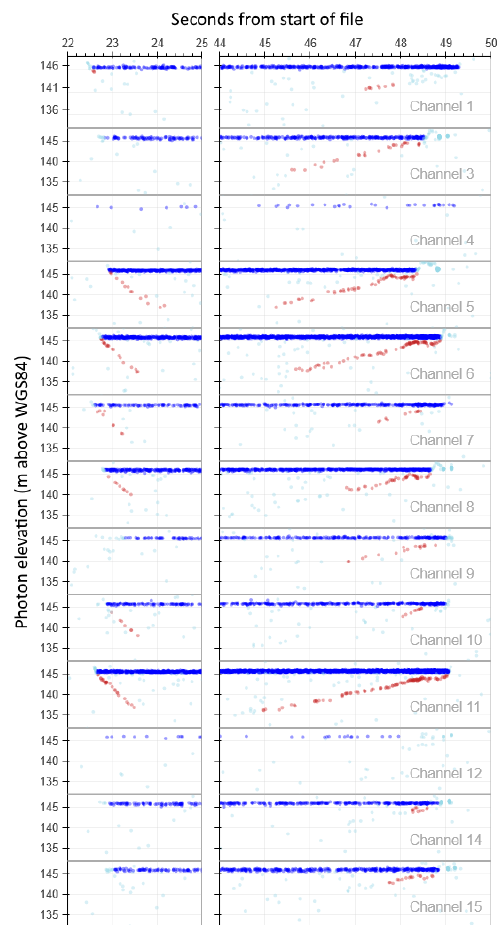
Figure 5. Surface returns (blue dots) and bottom returns (red dots) are shown for each green